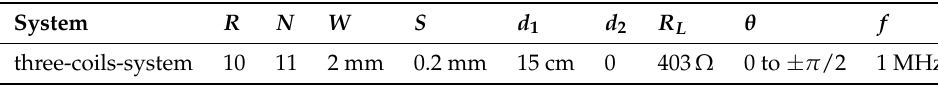
Table 1. Coil Parameters Of three-coils-receiver